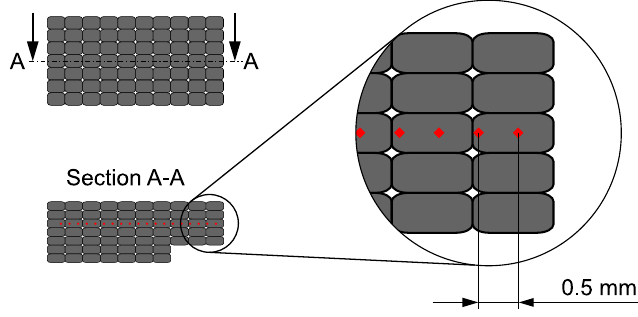
Figure 6. Measuring grid for micro-hardness measurement. The measuring points are located in the center of the sample in the vertical direction so that the hardness measurement is not distorted by possible edge influences. In the horizontal direction, the distance between the measuring points and the samples’ edges is maintained in accordance with DIN EN ISO 6507-1. The distance between the measuring points is 0.5